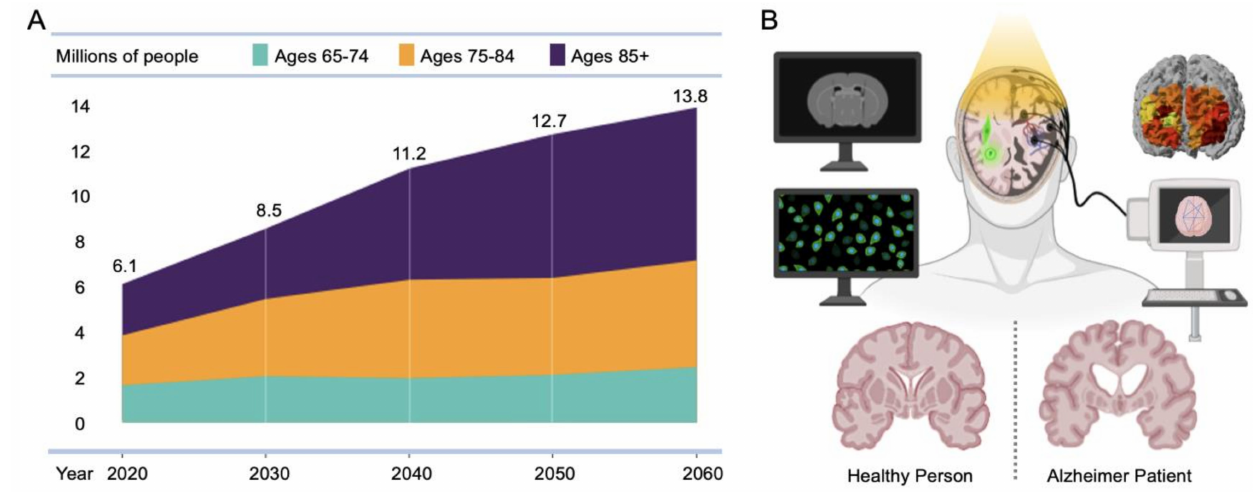
Figure 1. AD population and diagnostic neuroimaging modalities. ( A ) Projected number of people aged over 65 in the U.S. population with Alzheimer’s dementia from 2020 to 2060. Adapted from [1] with permission from John Wiley and Sons. ( B ) Multimodal neuroimaging modalities to diagnose AD patients.